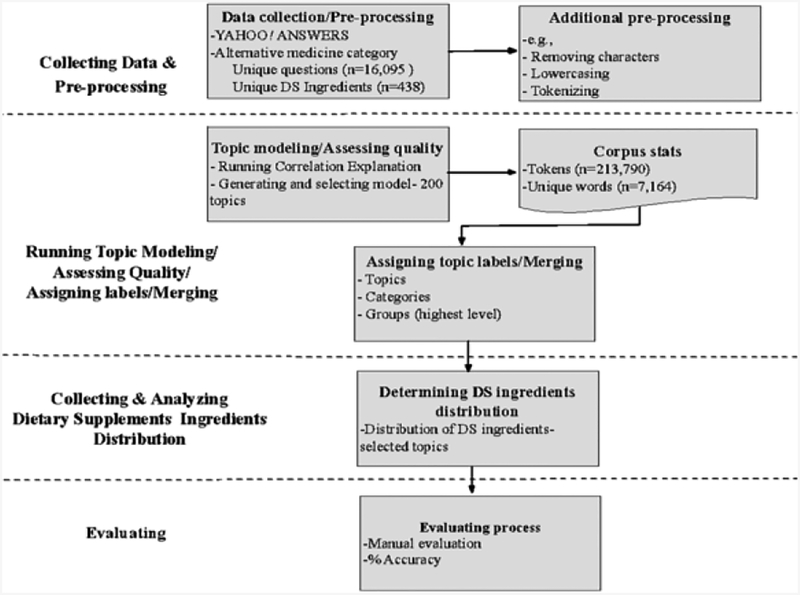
Process overview